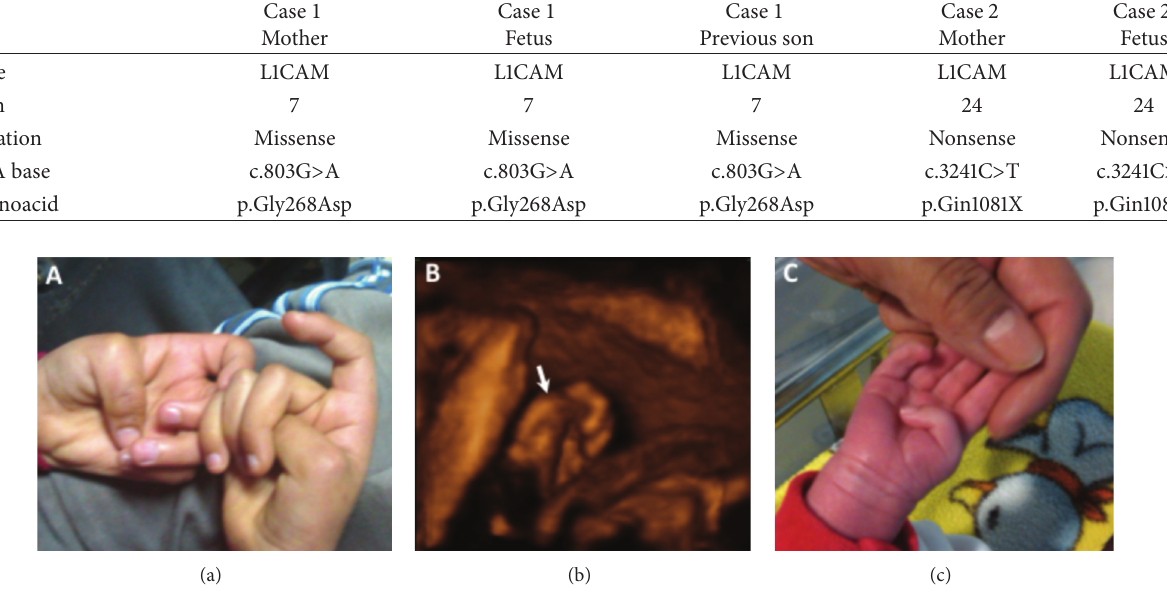
Figure 1: Case 1. (a) Picture of the hands in the index case shows bilateral adducted thumbs. (b) Surface-rendered three-dimensional ultrasound view shows adducted thumb in the fetus at 30 weeks (arrow). (c) Picture of the newborn infant shows adducted